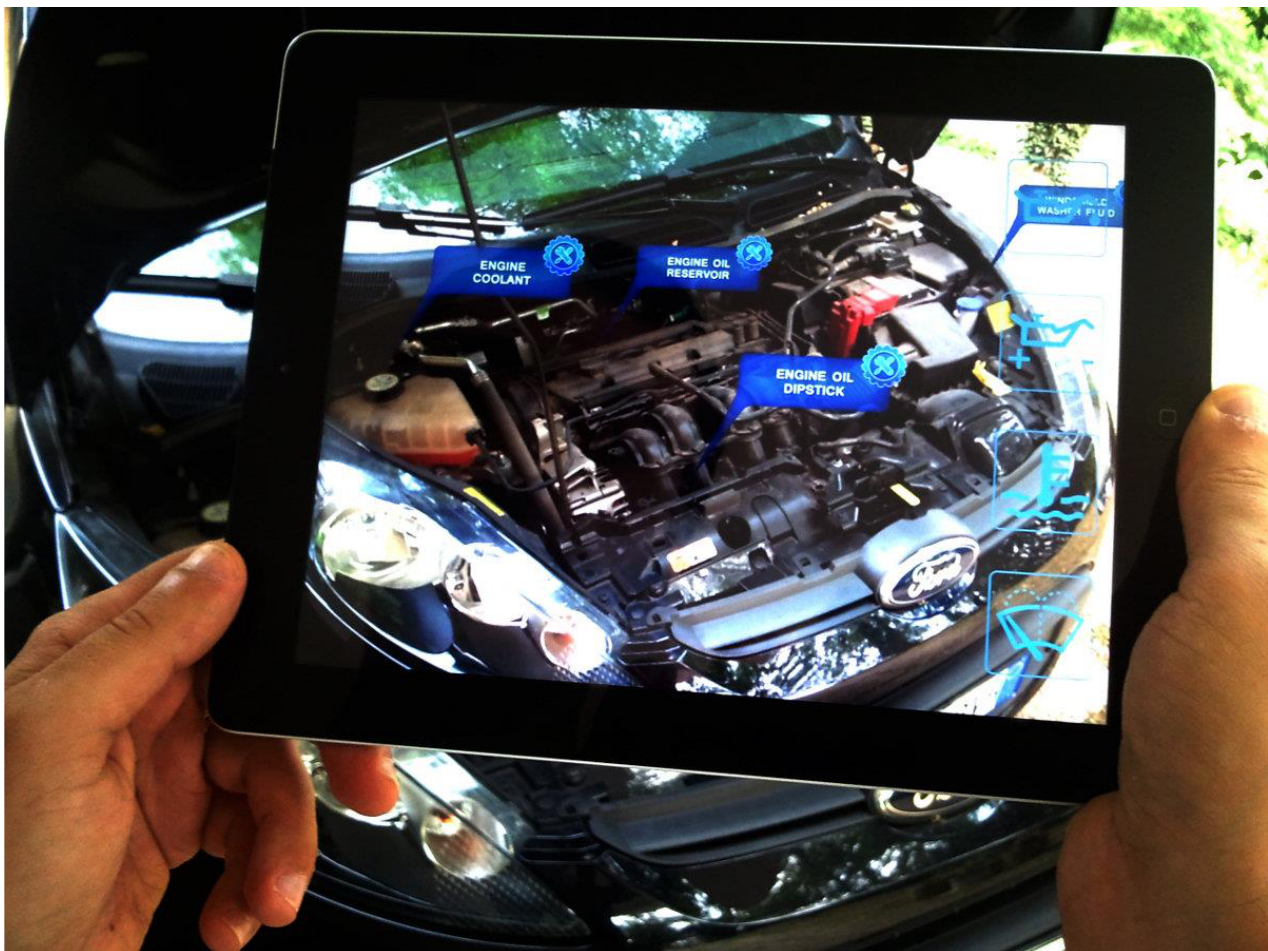
Figure 1. Scene From Ford’s AR repair help software [15].